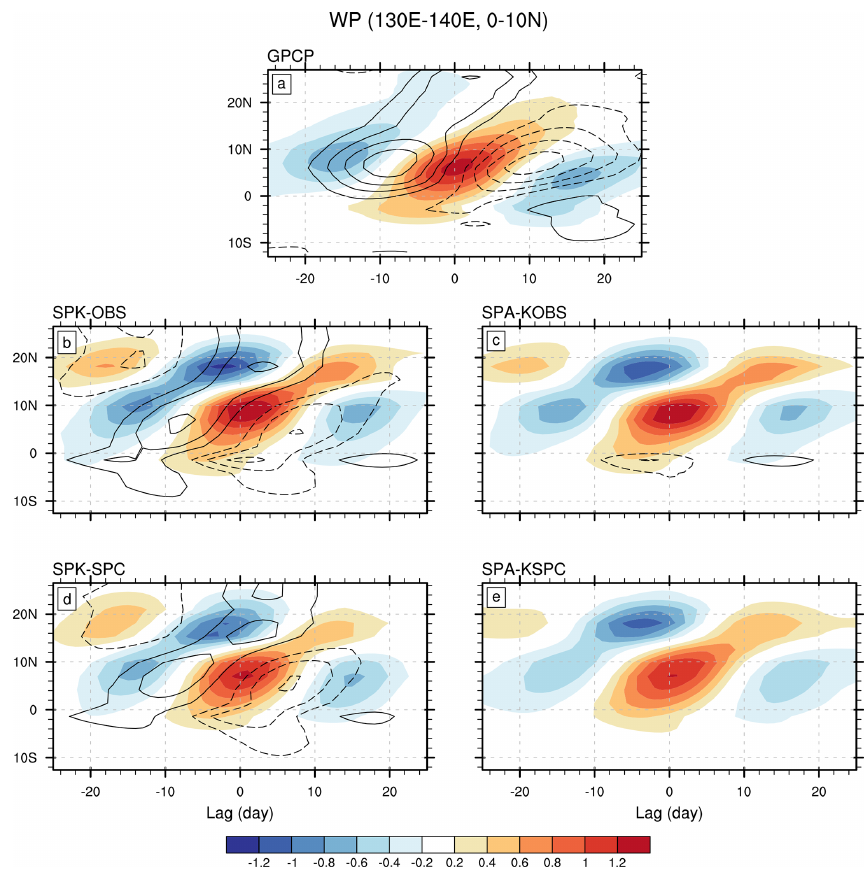
Figure 5. Same as Fig. 4, except for 130–140 ◦ E averaged intraseasonal precipitation and SST regressed onto (0–10 ◦ N, 130–140 ◦ E) aver- aged intraseasonal